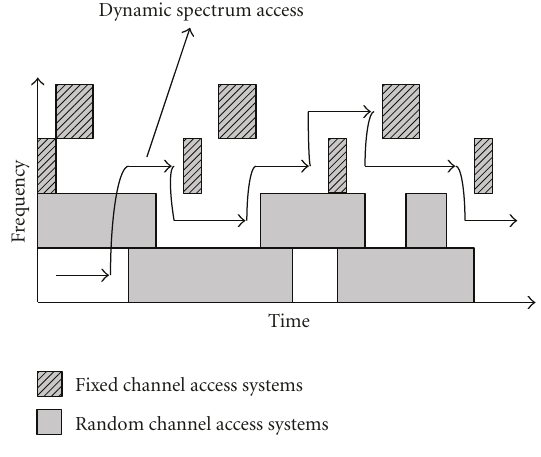
Figure 1: Concept of cognitive